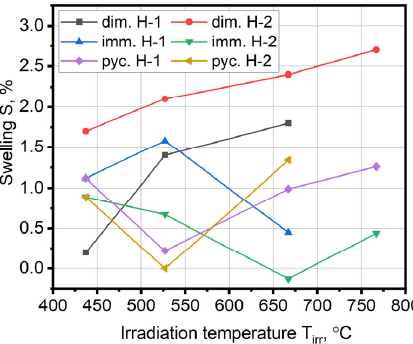
Figure 3. Dependence of swelling S of titanium beryllide Be-7Ti on irradiation temperature, reactor HFR, F = (0.73–1.82) · 10 22 cm − 2 (E > 1 MeV) (dim.—dimension, imm.—immersion, pyc.—pycnometry, H-1—HIDOBE-01, H-2—HIDOBE-02).